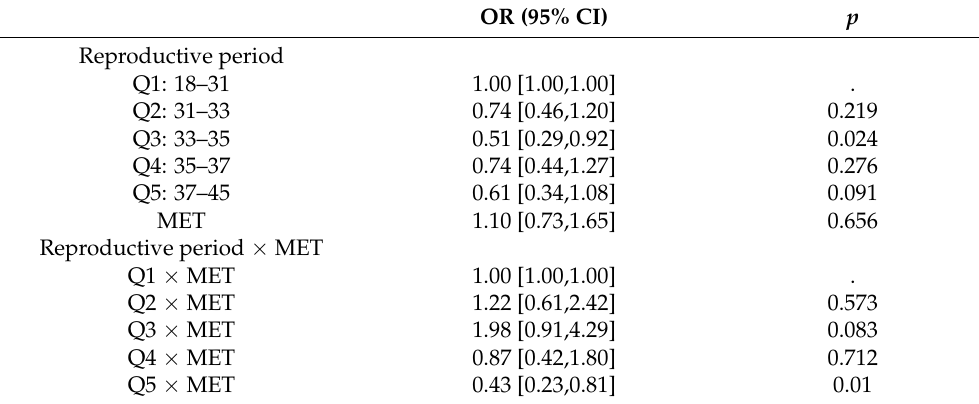
Table 3. The interaction of reproductive period and metabolic equivalent on decreased renal func- tion.